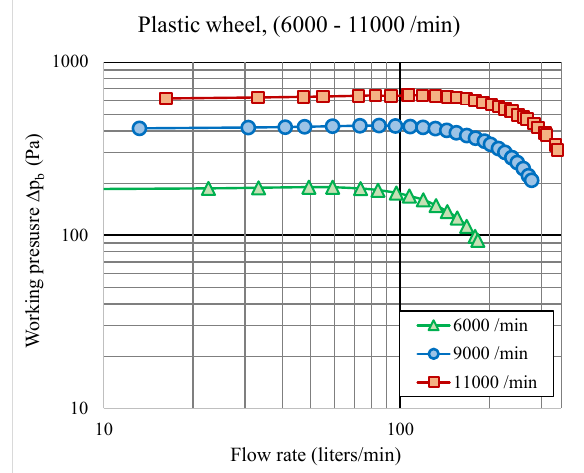
Fig. 7 Fan output for different motor